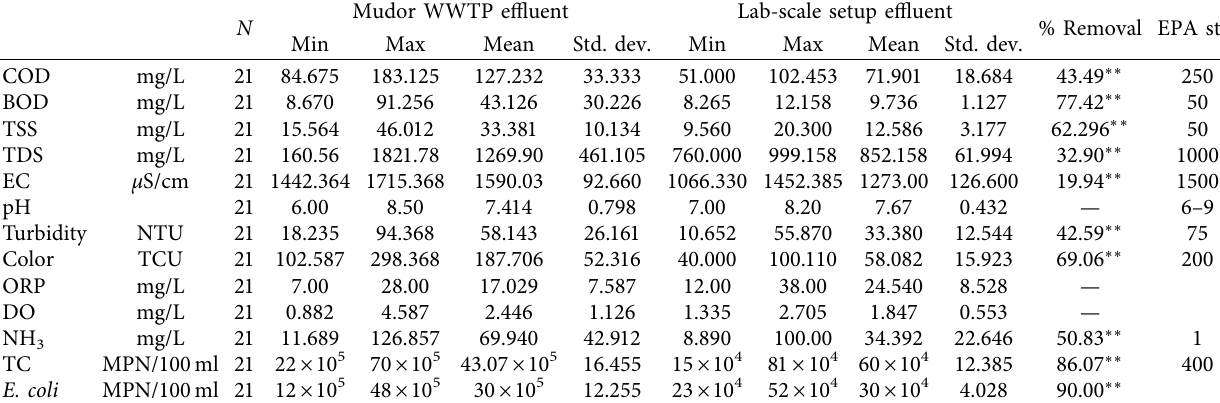
Table 3: Mean results for analyzed physicochemical and microbial characteristics of efuent samples for wk 2 of laboratory-scale fltration setup.